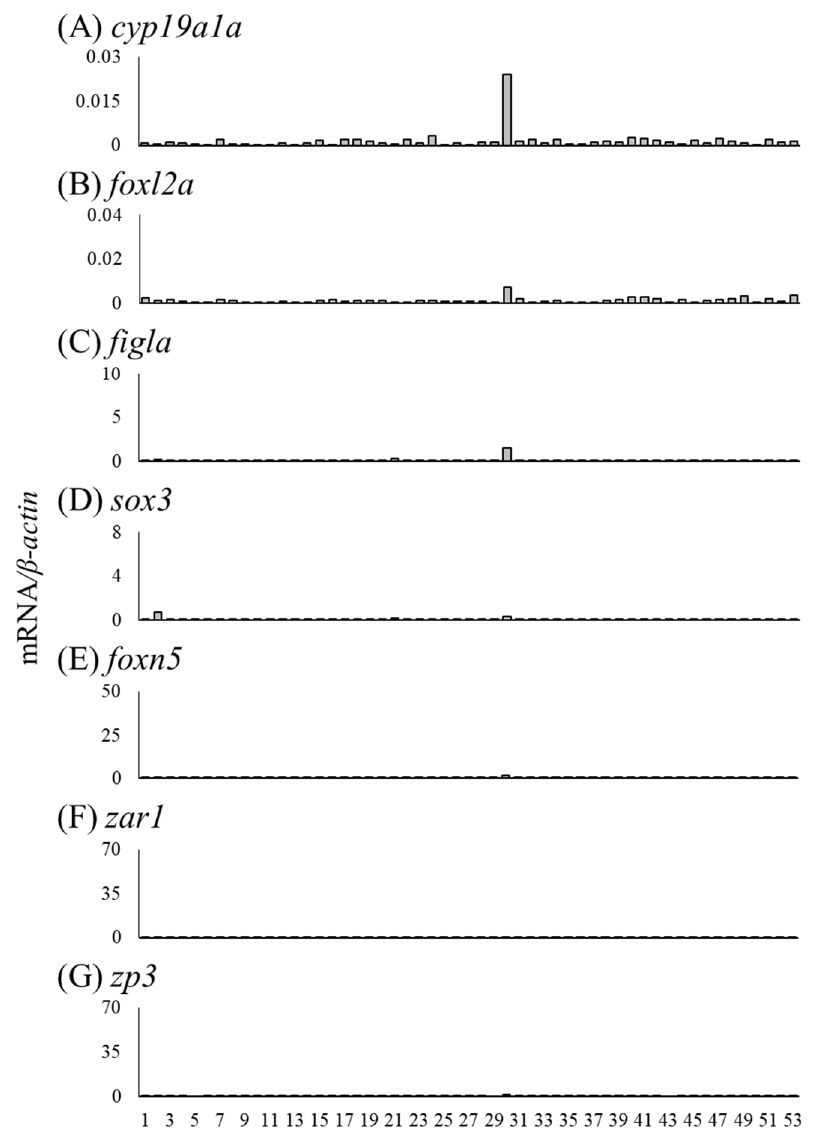
Figure 10. Messenger RNA levels of sex differentiation-related genes ( cyp19a1a , foxl2a , figla , sox3 , foxn5 , zar1 and zp3 ) in undifferentiated gonads of the wild Japanese eel Anguilla japonica. ( A ) cyp19a1a , ( B ) foxl2a , ( C ) figla , ( D ) sox3 , ( E ) foxn5 , ( F ) zar1 and ( G ) zp3 mRNA levels in undifferentiated gonads. Each column indicates mRNA levels normalized against levels of β -actin . TL in undifferentiated gonads, including testis-like and ovary-like structures (No. 1–53); for details, refer to Table 5.